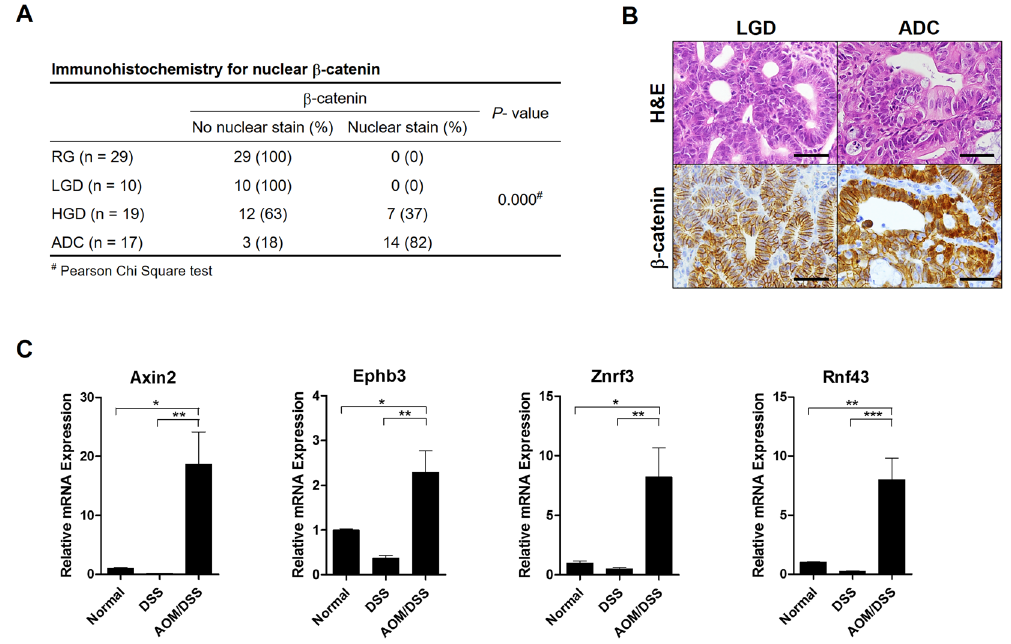
Figure 6. Enhanced Wnt signaling pathway in colitis-associated carcinogenesis. ( A ) Immunohistochemical analysis revealed that nuclear β -catenin staining was negative in all regenerative glands and low grade dysplasia (LGD) samples, but was positive in 37% of high grade dysplasia cases and 82% of adenocarcinomas (ADC). ( B ) Representative pictures of a LGD samples with membranous β -catenin and an ADC with strong cytoplasmic and nuclear β -catenin staining. Scale bar: 25 μ m ( C ) Other Wnt-target genes including Axin2, Ephb3, Znrf3, and Rnf43 were upregulated in the azoxymethane and dextran sodium sulfate (AOM/DSS) group compared to expression in the normal and control groups. (Normal: n = 3, DSS: n = 7, AOM/DSS: n = 5). * P < 0.05; ** P < 0.01; *** P <